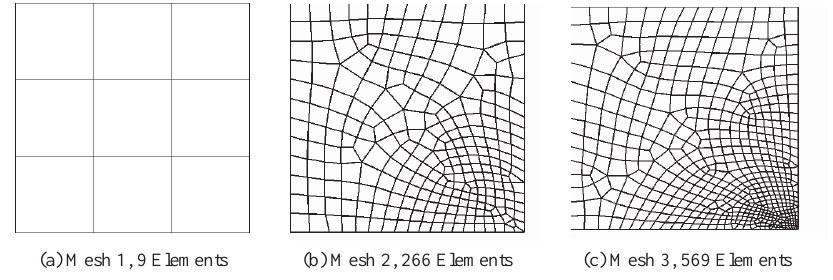
Fig. 2. Symmetric quadrant of a clamped square isotropic plate subjected to impact by a sphere at the center of the plate.